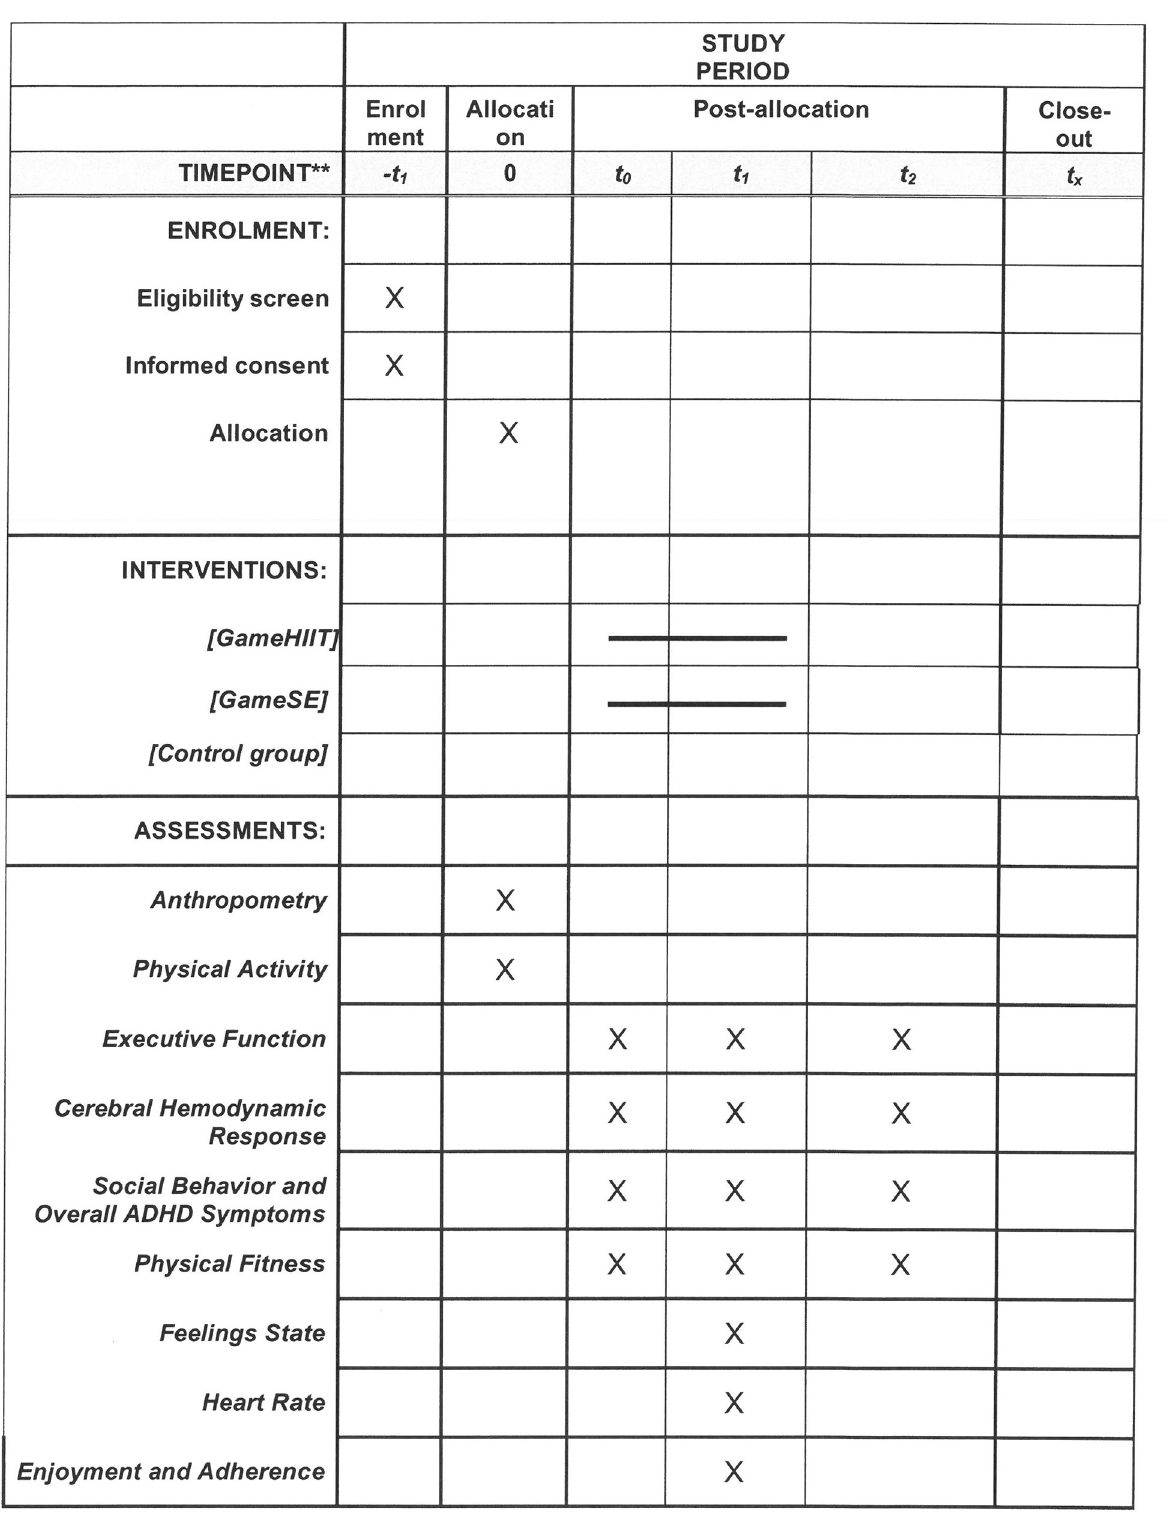
Fig 1. The schedule of enrolment, interventions, and assessments.